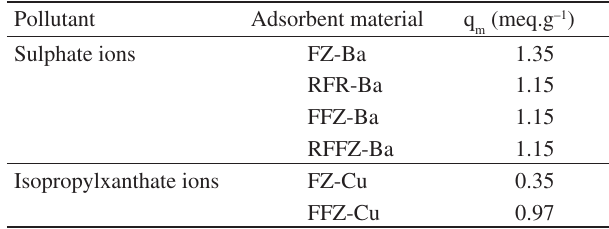
Figure 14. Reuse of flocculated (and saturated) zeolites. Equilibrium data (isotherm) for the sulphate ions uptake from aqueous solutions. Contact time: 2 hours, Ba-RFZ-Ba: 10 g.L –1 , temperature: 25 °C, pH: 6.0. Table 4. Summary of results – sulphate and isopropilxanthate removal